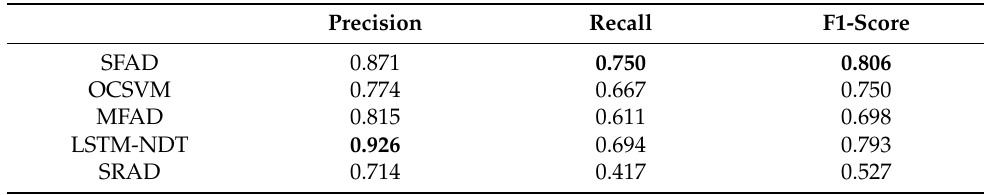
Table 6. Comparison of Anomaly Detection Results on the MSL Dataset.